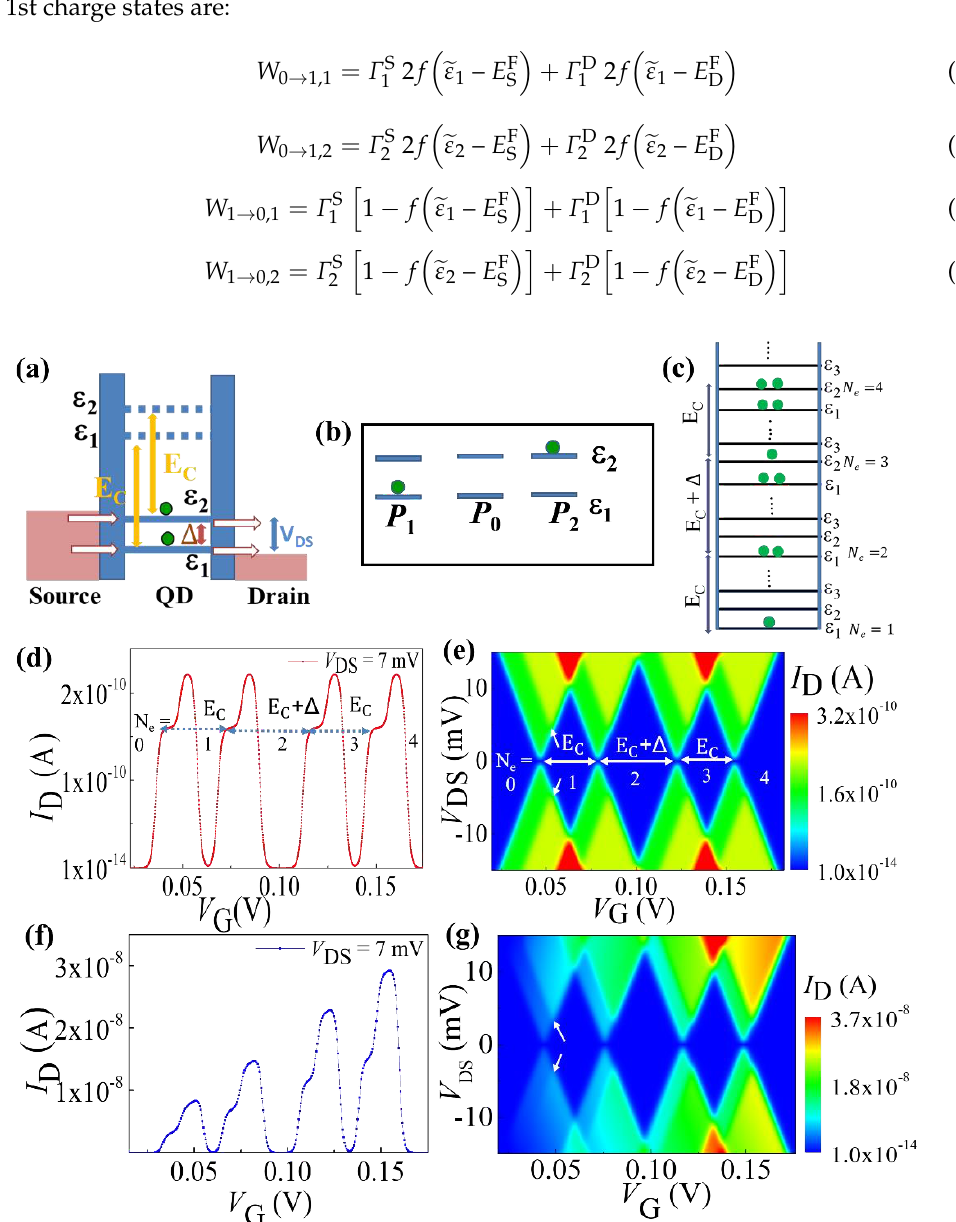
Figure 4. ( a ) Schematic representation of a QD with two energy levels accessible in the bias window, connected with source and drain reservoirs. ( b ) Probable transitions from |ϕ > ( P 0 ) to |ψ > ( P 1 and P 2 ) are shown. ( c ) Schematic representations of the successive incorporation of electrons in the QD for the quantum Coulomb blockade case. ( d , e ) I D − V G characteristics and stability diagram of a SET system with constant bare tunnel rates, respectively. ( f , g ) I D − V G characteristics and stability diagram of a practical SET setup with biasing-dependent tunnel rates, respectively. Arrows indicate the onset of transport through a new energy level.